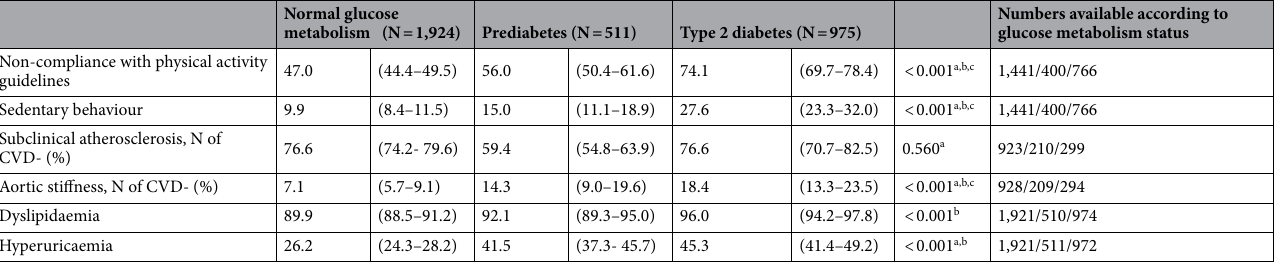
Table 1. Age- and sex- adjusted prevalences of comorbidities, classical complications and cardiometabolic risk factors according to glucose metabolism status. The descriptive variables are presented as mean ± SD, median [interquartile range (IQR)], or frequencies (in %) as appropriate. Linear trend was tested with an analysis of variance or a chi-square test as appropriate. Differences among groups of glucose metabolism status were tested with an independent t-test, or chi-square test, as appropriate. The comorbidities, classical complications and cardiometabolic risk factors are presented as age- and sex-adjusted prevalences (with normal glucose metabolism as reference category) in percentages with their 95% confidence interval (CI). Age- and sex-adjusted linear trend and differences among groups of glucose metabolism status were tested with a (multinomial) logistic regression analyses (with normal glucose metabolism or prediabetes and the lowest category as reference group). a Prediabetes versus normal glucose metabolism, P < 0.05. b Type 2 diabetes versus normal glucose metabolism, P < 0.05. c Type 2 diabetes versus prediabetes, P < 0.05. Other P -values > 0.05. d Diabetes duration was available in 664 individuals with type 2 diabetes; 133 of 975 individuals with type 2 diabetes had newly diagnosed type 2 diabetes.